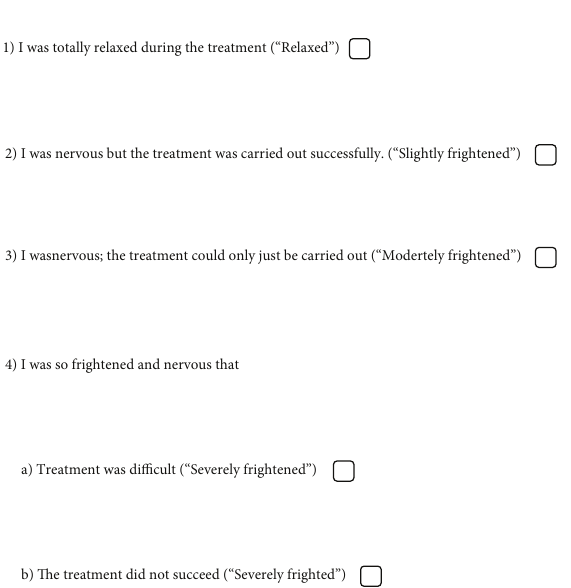
Figure 1: The SDFQ and clinical classification of patient’s